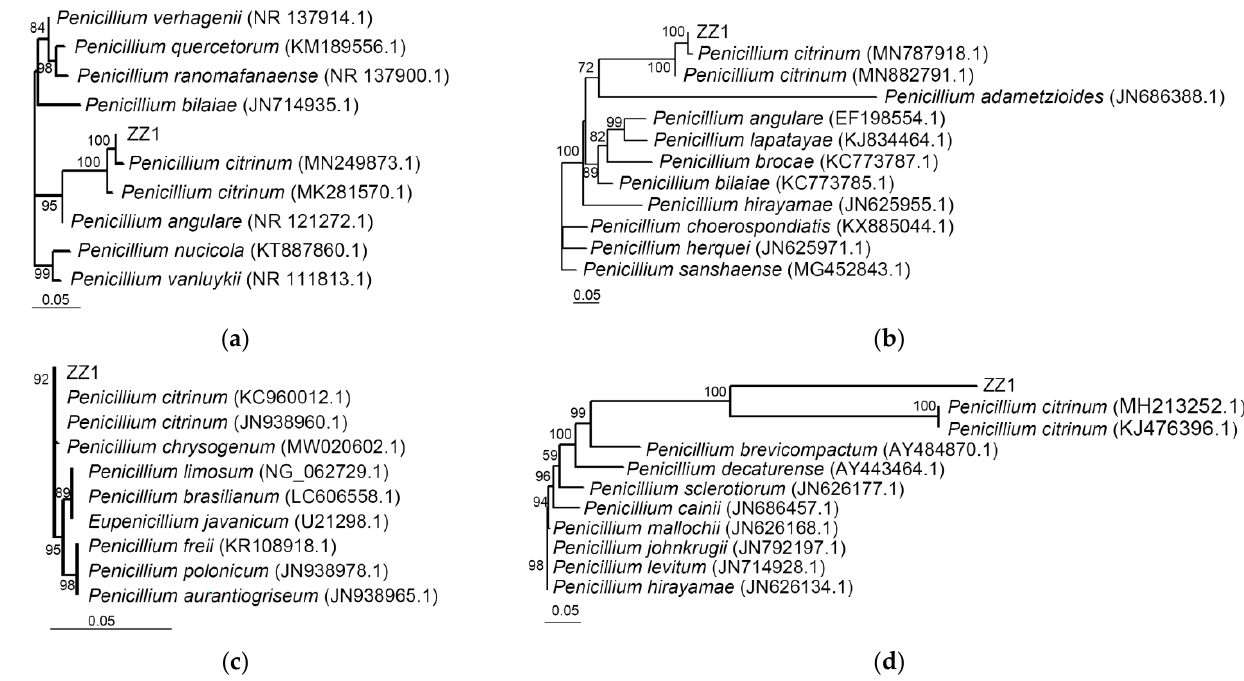
Figure 8. Phylogenetic analysis of strain ZZ1 and its relatives based on the nucleotide sequences of ITS ( a ) the genes encoding β -tubulin ( b ), ssu ( c ) and EF-1a ( d ).